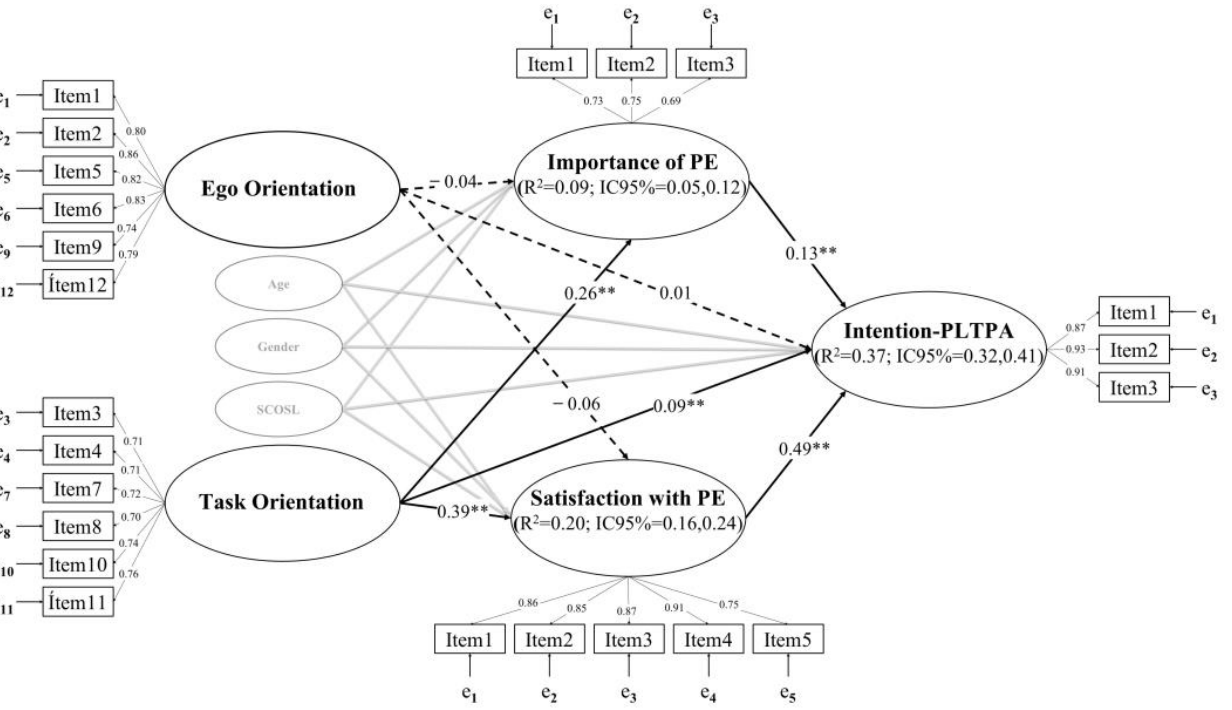
Figure 2. Predictive relationships of dispositional goal orientations on the intention to partake in leisure time physical activity through the mediation of the importance and usefulness of Physical Education and satisfaction/fun with Physical Education. Note: ** p < 0.01; SCOSL = sports competition outside of school lessons; PE = Physical Education; Intention-PLTPA = intention to partake in leisure time physical activity; R 2 = explained variance; CI = confidence interval. Dashed lines represent non-significant relationships. The SEM was controlled for gender, age, and sports competition outside school lessons during the week. Table 2. Estimation of significant standardized parameters and statistics of the mediation model.